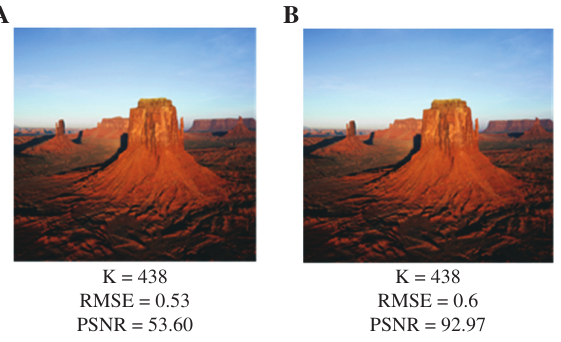
Figure 7: Compressed Results.